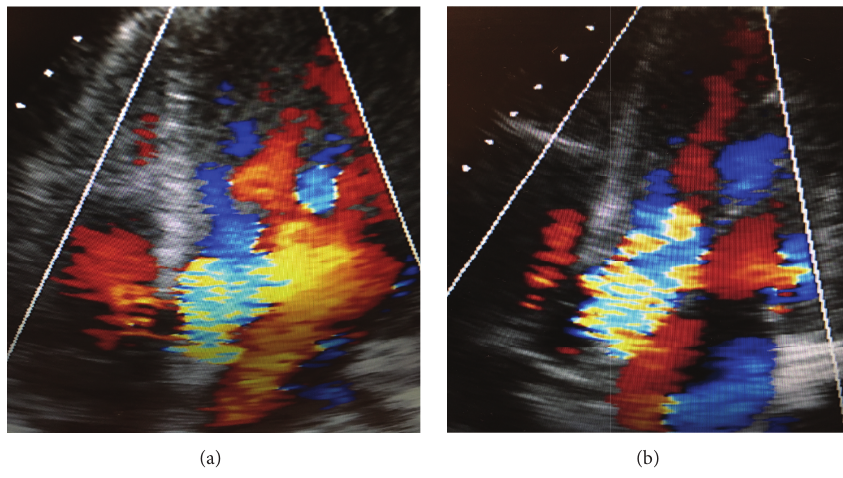
Figure 6: Echocardiogram five-chamber view showing severe aortic